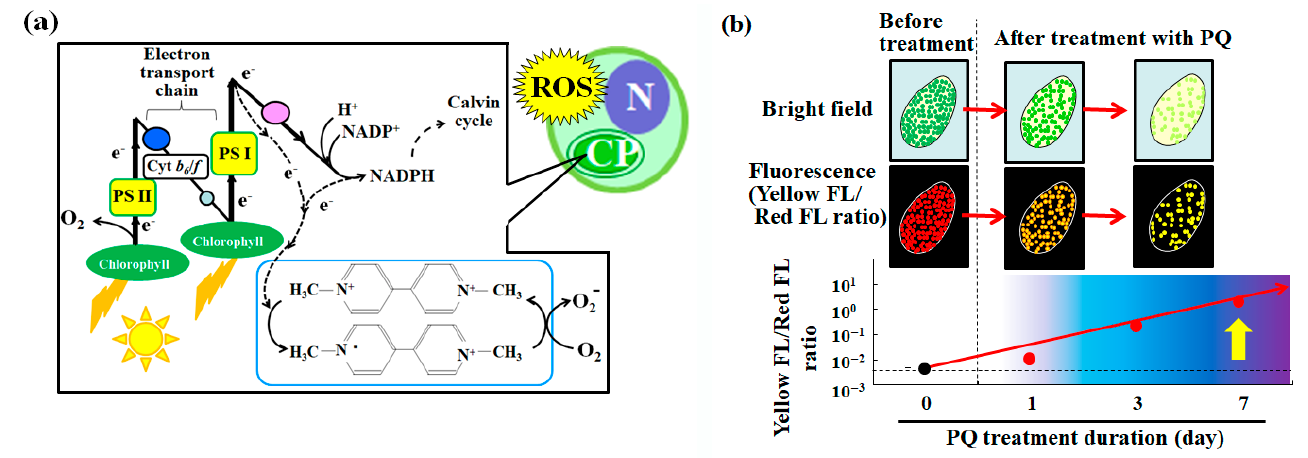
Figure 6. The effect of the herbicide PQ on photosynthesis and the evaluation of endosymbiotic algal vitality in P. bursaria using the yellow/red fluorescence intensity ratio. ( a ) Mechanism of photosynthesis-related PQ toxicity and the associated reactive oxygen species (ROS) production [52]. The acronyms PS, Cyt, N, and CP, respectively, denote photosystem, cytochrome, algal nucleus, and chloroplast. ( b ) Conceptual diagram of the devised method for the evaluation of the endosymbiotic algal vitality in P. bursaria cells using the yellow/red fluorescence intensity ratio as a stress index.